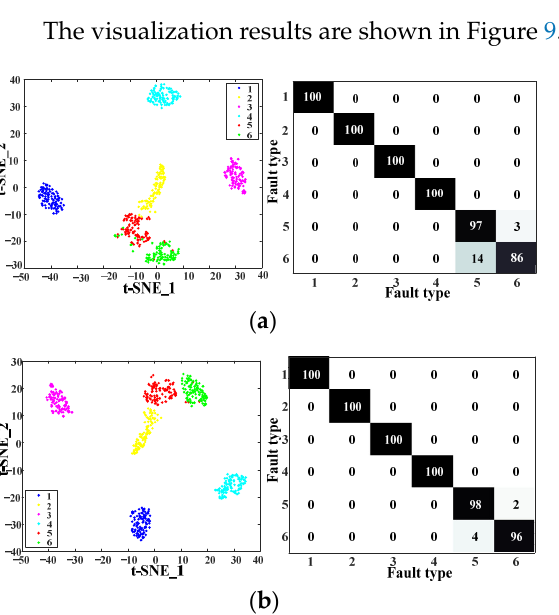
Figure 9. ( a ) Visualization and prediction error matrix of CNN. ( b ) Visualization and prediction error matrix of SDGD-CNN.